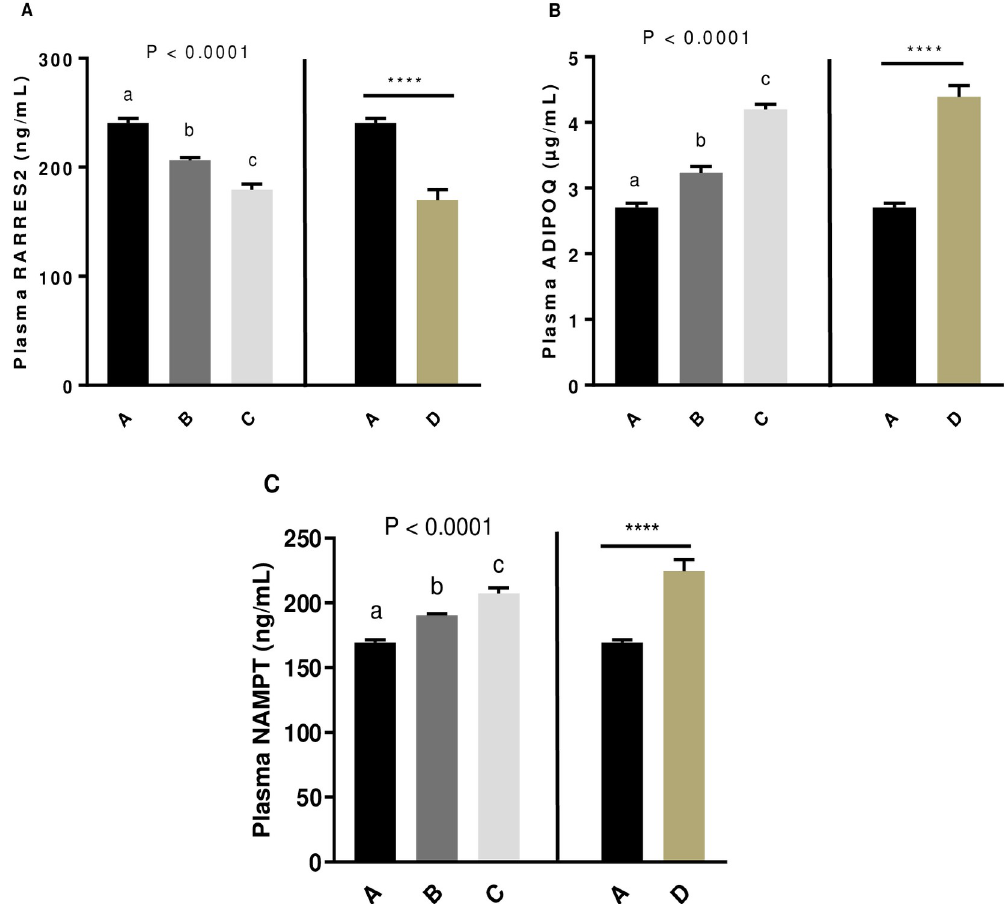
Fig 6. Level of plasma RARRES2 (A), ADIPOQ (B) and NAMPT(C) concentrations of broiler hens fed with different concentrations of GSE dietary supplementation. At 33 rd week, plasma adipokines concentration was assessed using specific ELISA assay in 11 animals from each group of animals. A: animals fed with control diet without GSE supplementation, B and C: animals supplemented with GSE at 0.5% and 1% of the total diet composition, respectively, starting at 4 week-old until 40 week-old, and D: supplementation at 1% of the total diet composition starting at hatch until 40 week-old. Results are presented as lsmeans ± S.E.M. P values and different individual letters indicate a significant effect of the diet between A, B and C groups (experiment 1) or between A and D groups (experiment 2). P value was considered as significant if P < 0.05. ���� P <